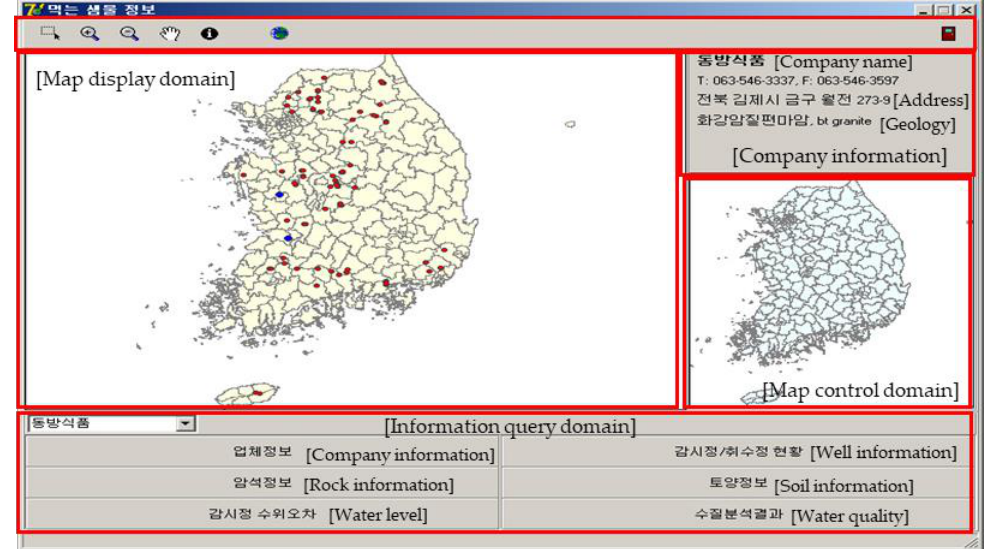
Figure 5. The basic environment of the integrated management system (IMS) for the mineral water management.